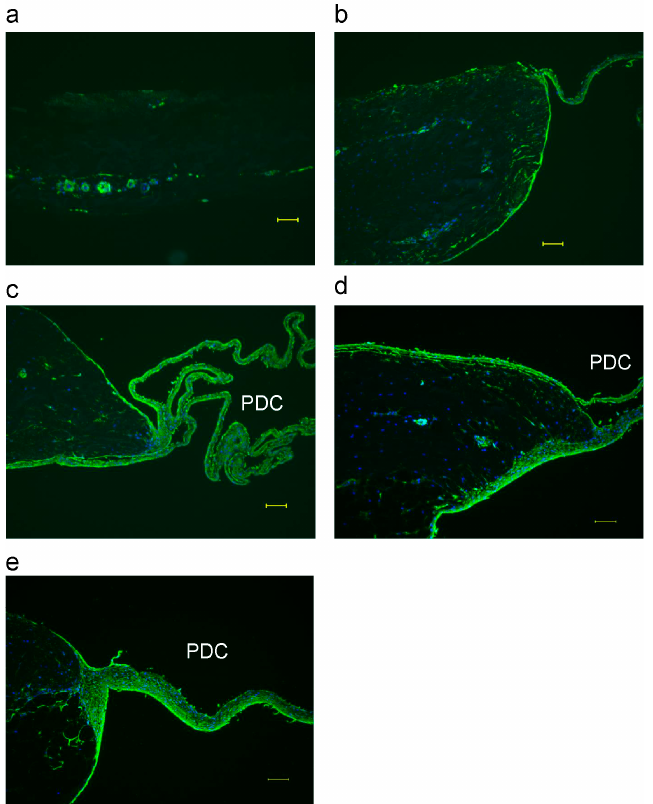
Figure 3. α SMA-positive cells increased during explant culture: ( a – e ) Fluorescent immunostaining of the periosteum. α SMA: green, DAPI: blue. PDC: Periosteum-derived cells at ( a ) 1 week; ( b ) 2 weeks; ( c ) 3 weeks; ( d ) 4 weeks; and ( e ) 5 weeks. Scale bar: 100 μ m. From 6 to 7 weeks, a comparison of EVG imaging (Figure 4a,e) and fluorescent im- munostaining of FBXW2 (Figure 4b,f) and α SMA (Figure 4c,g) showed that elastic fibers and FBXW2 were present in the same regions in microvessels. A comparison of fluorescent immunostaining of FBXW2 and osteocalcin (Figure 4d,h) showed that osteocalcin was not expressed around a part of the microvessels.